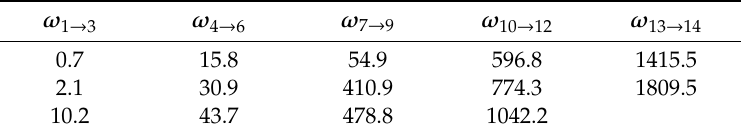
Table 4. Natural frequencies, ω n (rad / s) 1 .